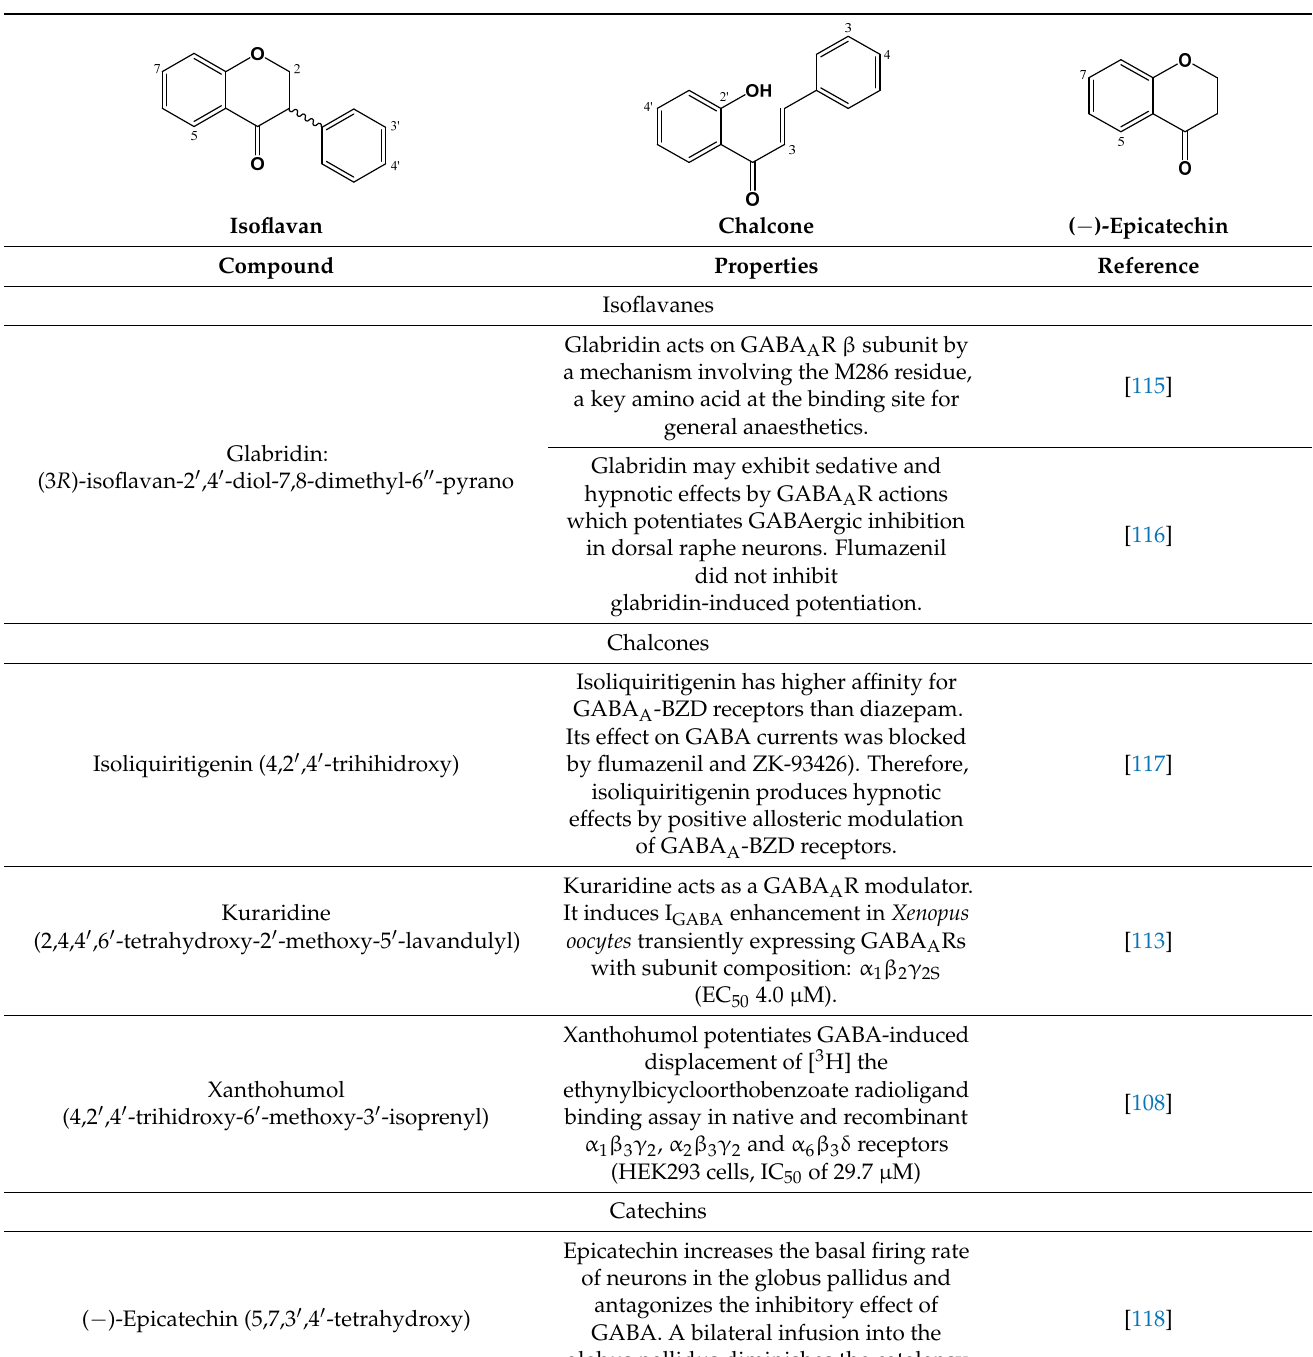
Table 4. Other flavonoids with relevant GABAergic effects.